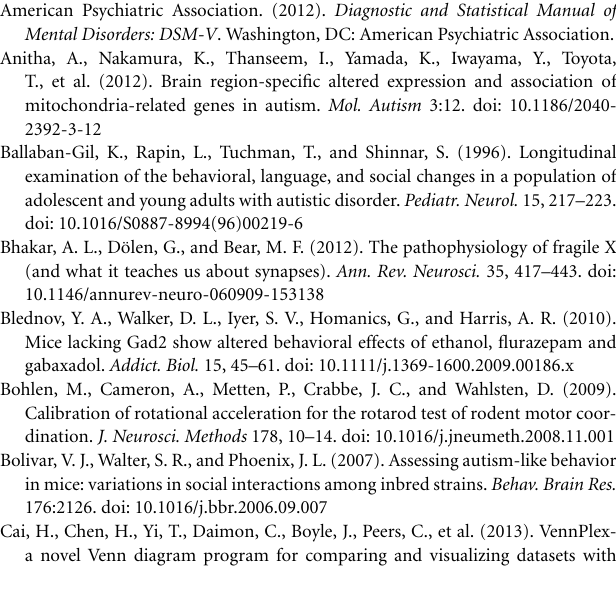
Figure S1 | Collective Textrous! analysis of differentially-regulated cortical protein subsets. Functional hierarchical word-clouds were generated from the upregulated (BTBR:WT iTRAQ ratio > 1.2) (A) and downregulated (BTBR:WT iTRAQ ratio < 0.8) cortical protein data sets. Figure S2 | Collective Textrous! analysis of differentially-regulated hippocampal protein subsets. Functional hierarchical word-clouds were generated from the upregulated (BTBR:WT iTRAQ ratio > 1.2) (A) and downregulated (BTBR:WT iTRAQ ratio < 0.8) hippocampal protein data